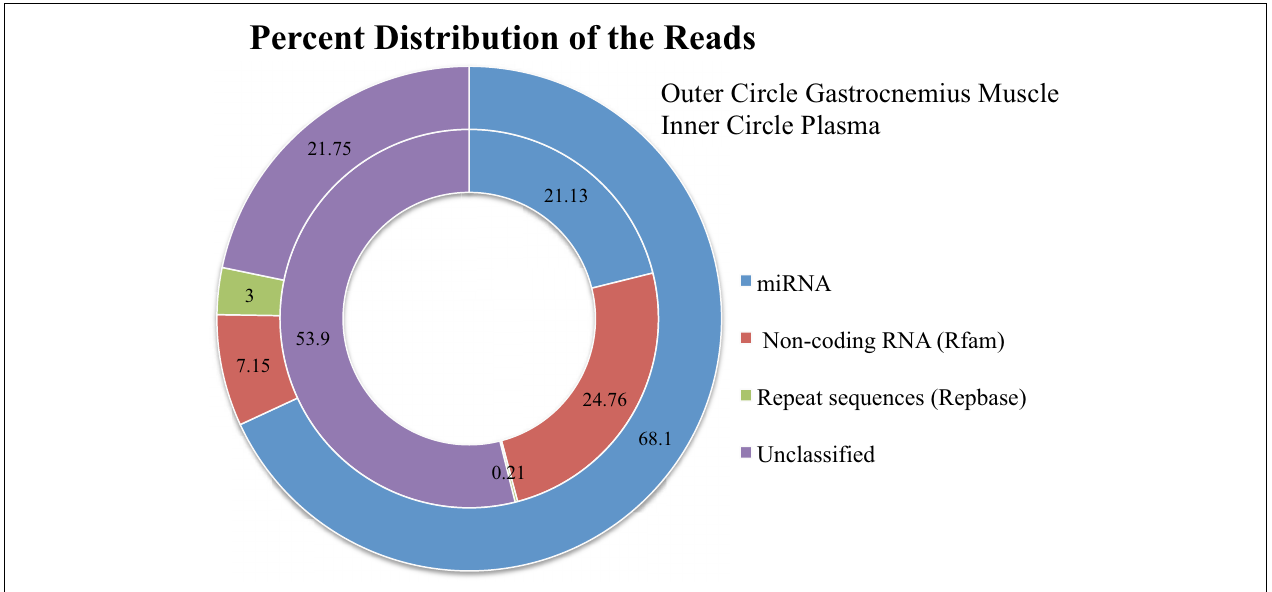
FIGURE 4 |The distribution of the total reads to different categories of known RNA sequences after removing adaptor-only and poor quality reads.